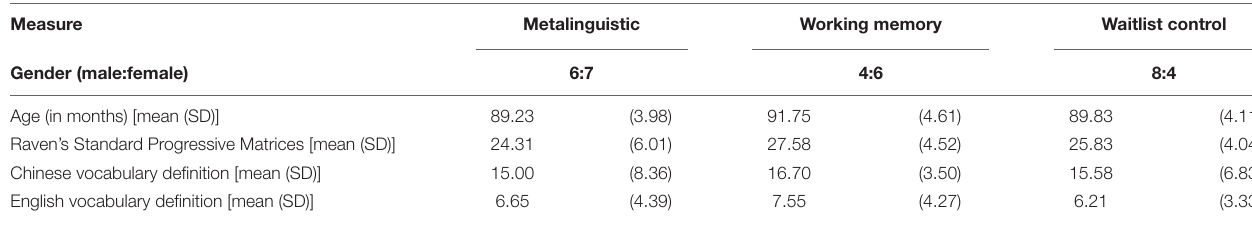
TABLE 1 | Group characteristics for training and control